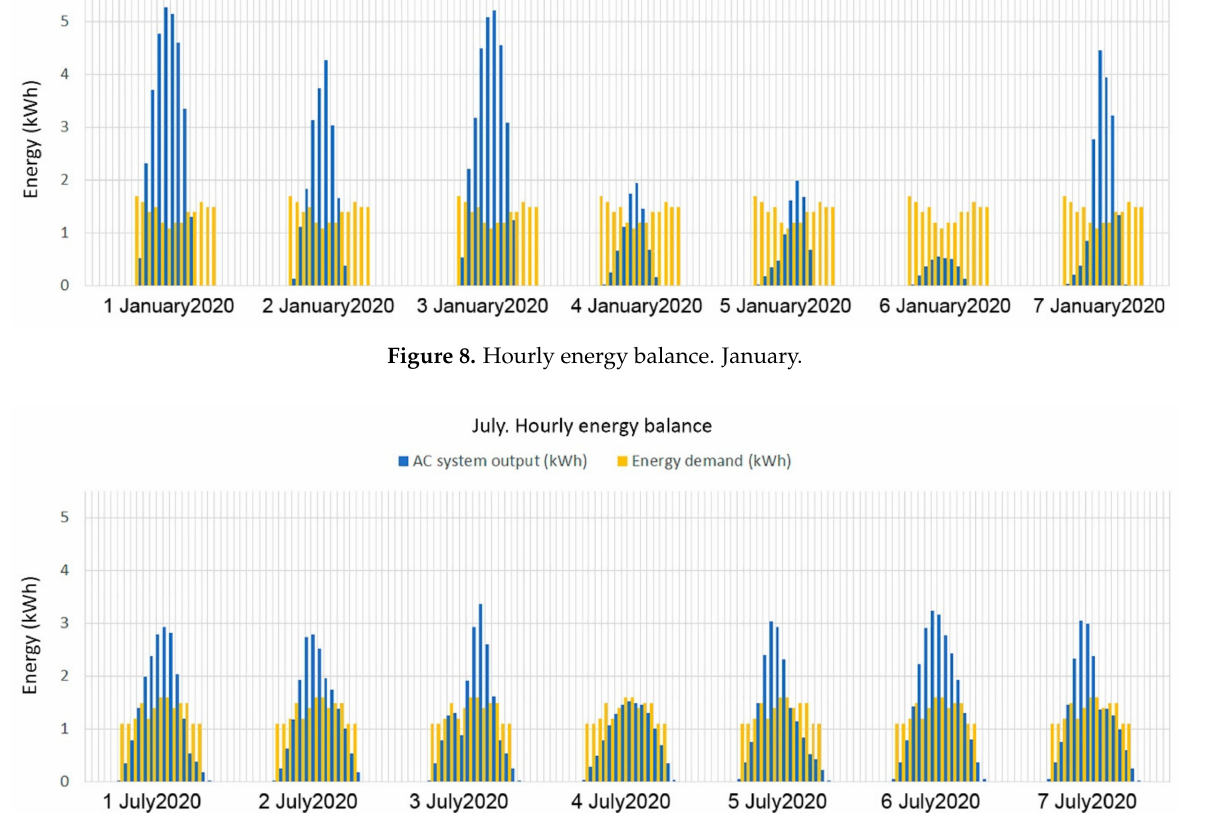
Figure 9. Hourly energy balance.